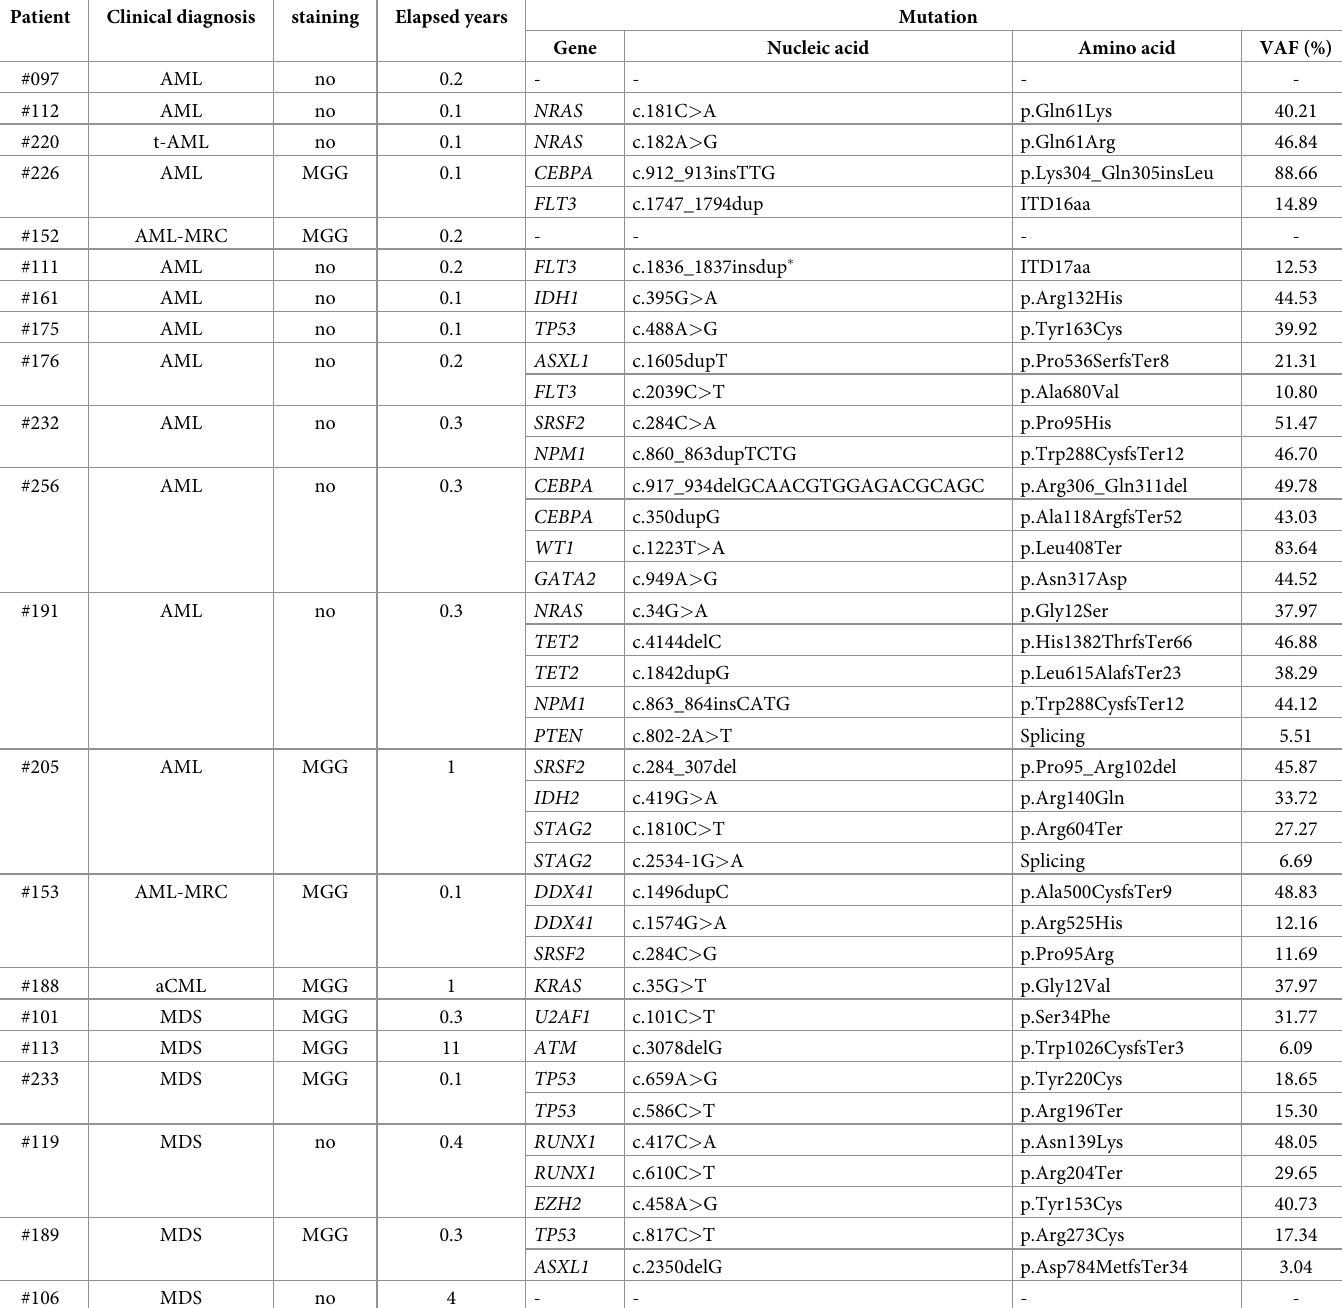
Table 2. List of patients, sample status, and pathogenic genes detected in the DNA/RNA target sequencing data of the smear